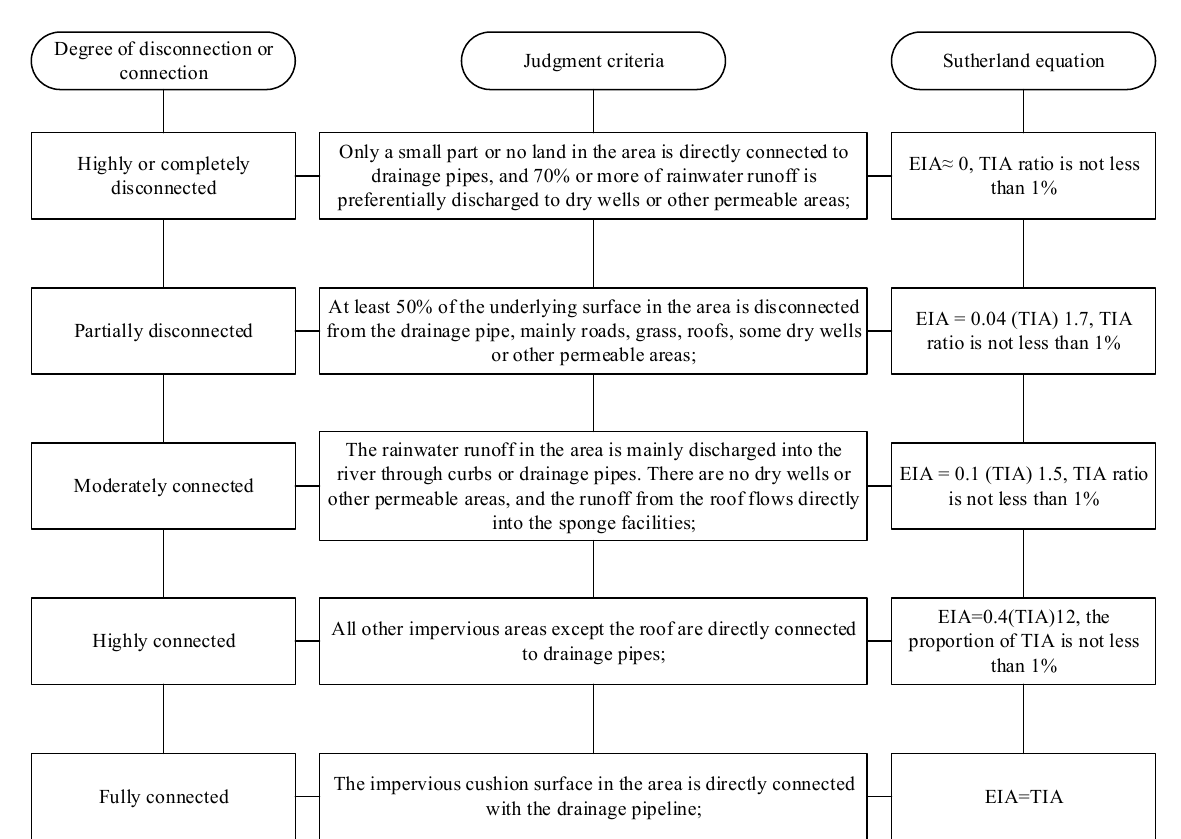
Figure 3. Effective impervious area (EIA) obtained by Sutherland equation.